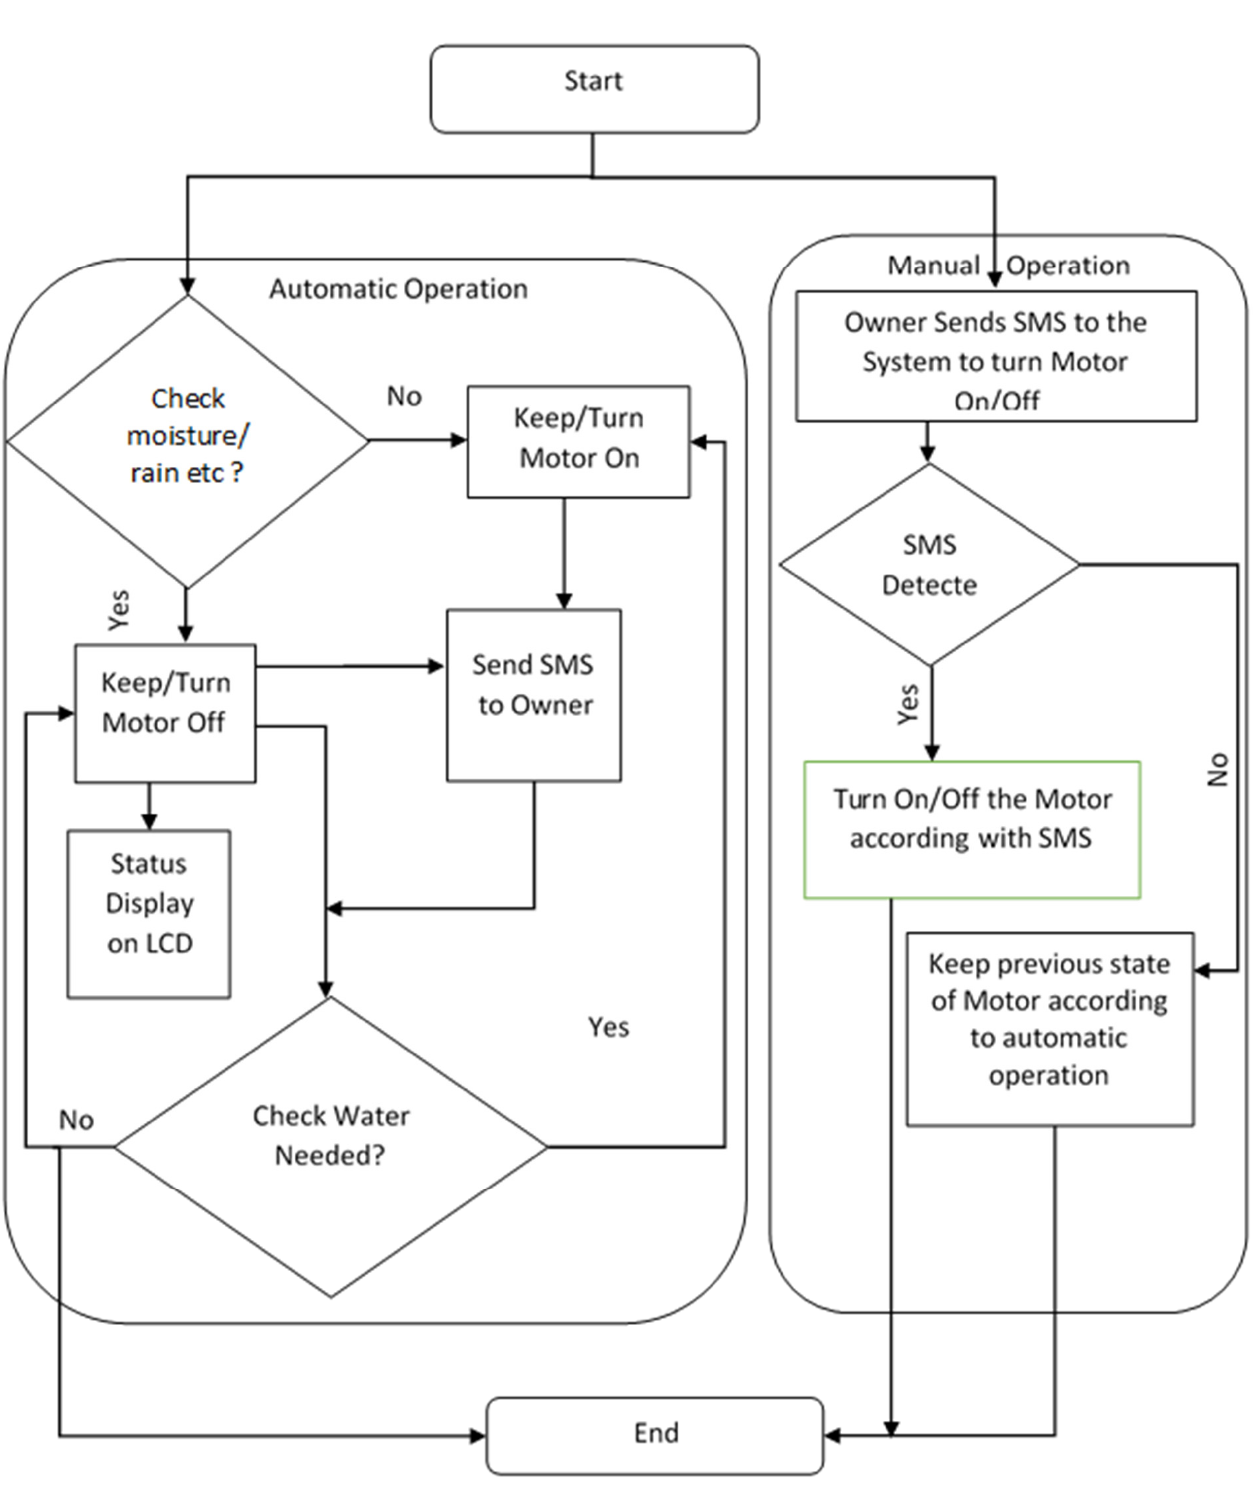
Figure 3. Flow chart of controlled sequence commands to operate tube well in manual or automatic mode.